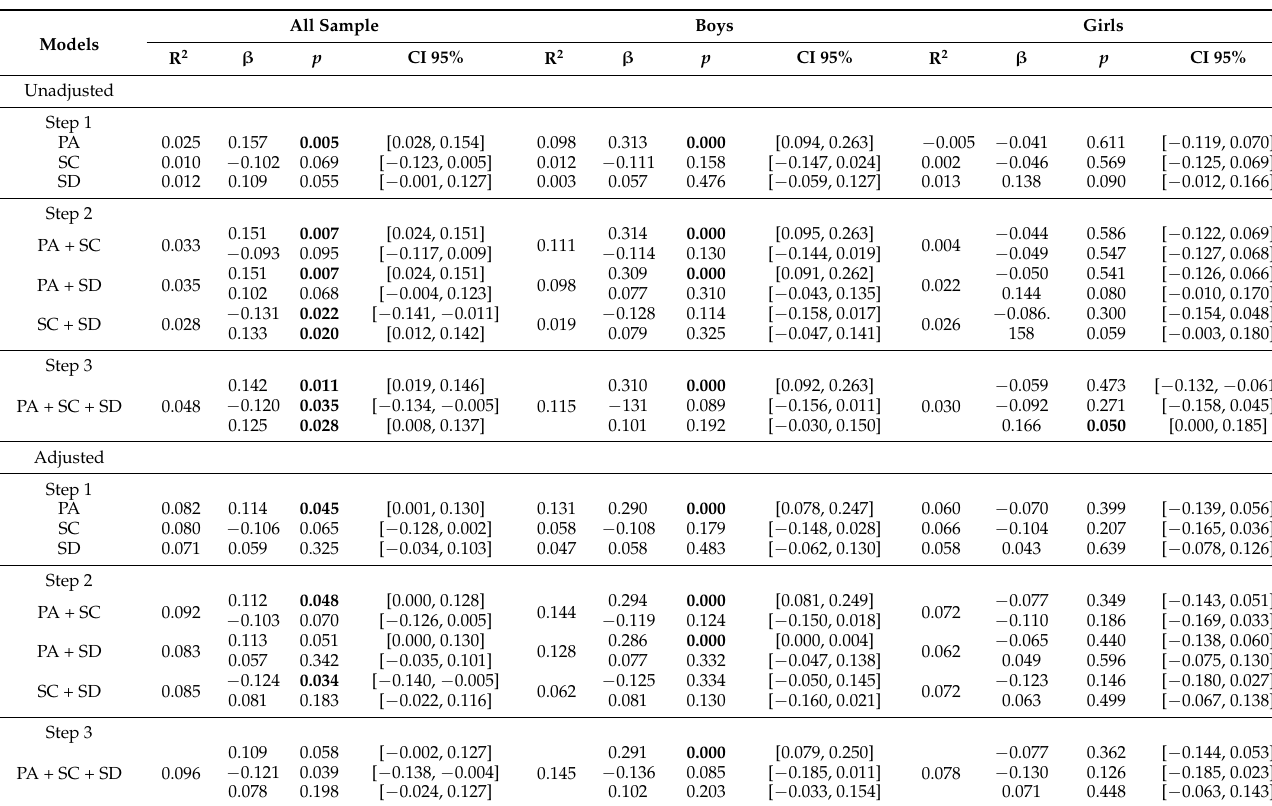
Table 2. Associations between each of the three movement behaviors (physical activity, screen time, and sleep duration) and quality of life in the whole sample and by